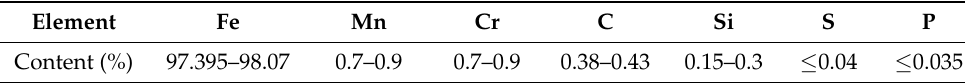
Table 2. Mechanical properties of AISI 5140 steel.